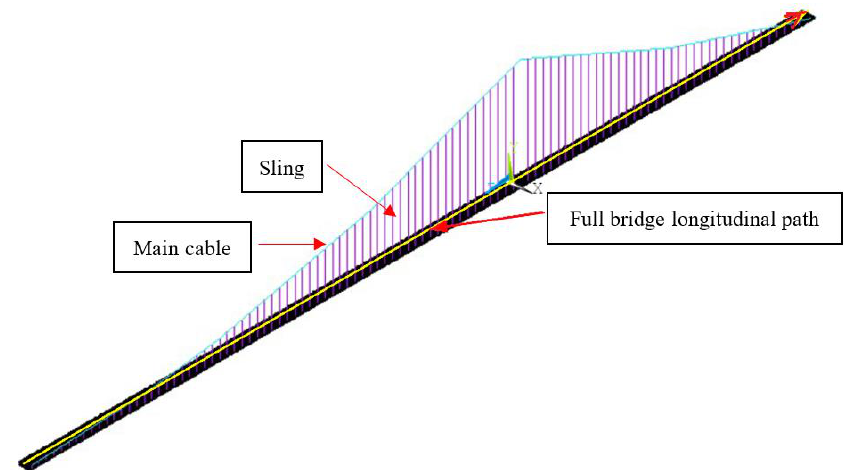
Figure 1. Numerical simulation and calculation model of Dasha Waterway Bridge of Nansha Bridge.